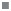
Comparison of the neutralizing capacity of the antivenom manufactured by INS-COL (A-C), PROBIOL (D-F), ICP (G-I) towards the edematogenic effect caused by the venom of B. asper (sensu stricto) (A, D, G), B. rhombeatus (B, E, H) and B. ayerbei (C, F, I). Edema was measured as the increase in the thickness of footpad compared to the negative control (PBS) and monitored during 6 h after subcutaneous injection of 5 μg of venom (●) mixed with antivenom in the ratios: 1000 μL antivenom/mg venom (○), 500 μL antivenom/mg venom (Δ), 250 μL antivenom/ mg venom (■). Each point represents the mean ± SD of four replicates. Statistically significant differences (p<0.05) compared to the venom control are represented by asterisks.